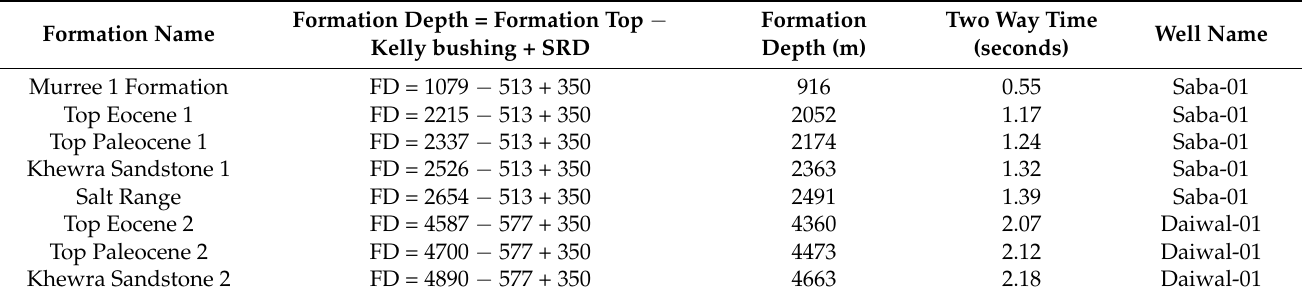
Table 3. Marking of horizons on control line through well to seismic tie.